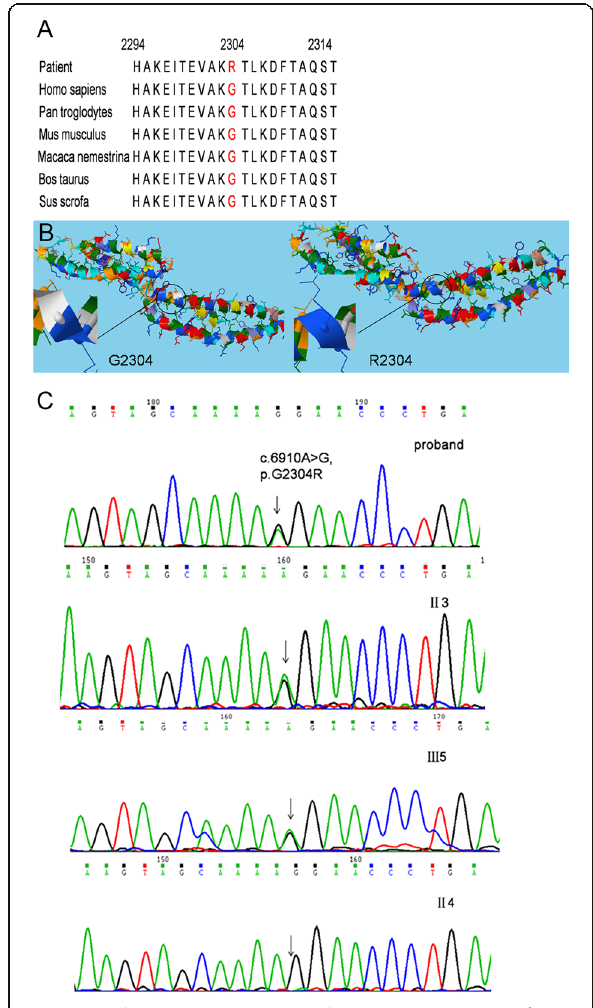
Fig. 6 a Evolutionary conservation analysis. Protein sequences of Homo sapiens (NP_006715473), Pan troglodytes (NP_016812220), Mus musculus (NP_011241489), Macaca nemestrina (NP_011751944), Bos Taurus (NP_010806995), Sus scrofa (NP_013847930) were retrieved from protein BLAST. b Secondary structures of SYNE1 with native Gly 2304 residue and Arg mutation. The structures of nesprin-1 with native Gly 2304 residue and Arg mutation were generated by Raptor 3D prediction program. The wild-type and mutant residues were colored with white and blue . Mutation p.G2304R altered the side chain of residue at position 2304. (For interpretation of the references to color in this figure legend, the reader is referred to the Web version of this article). c DNA sequencing chromatograph of exon 46 of the SYNE1 gene (abnormal and normal), SYNE1 gene with a heterozygous mutation: c. 6910 A>G (p. G2304R). The arrow pointed the